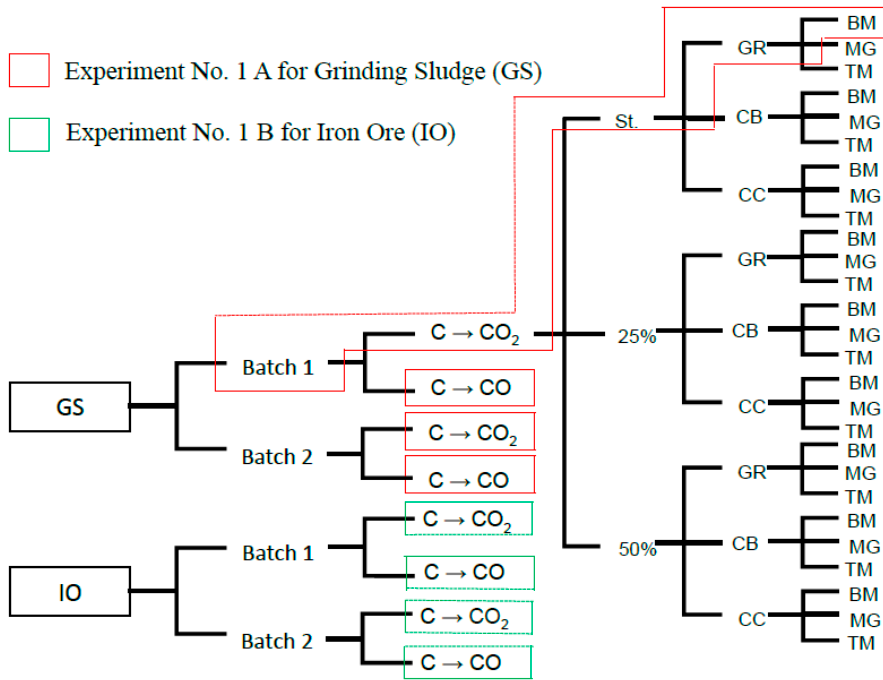
Figure 4. Tree diagram for the mixing of iron oxide and the carbonaceous material.